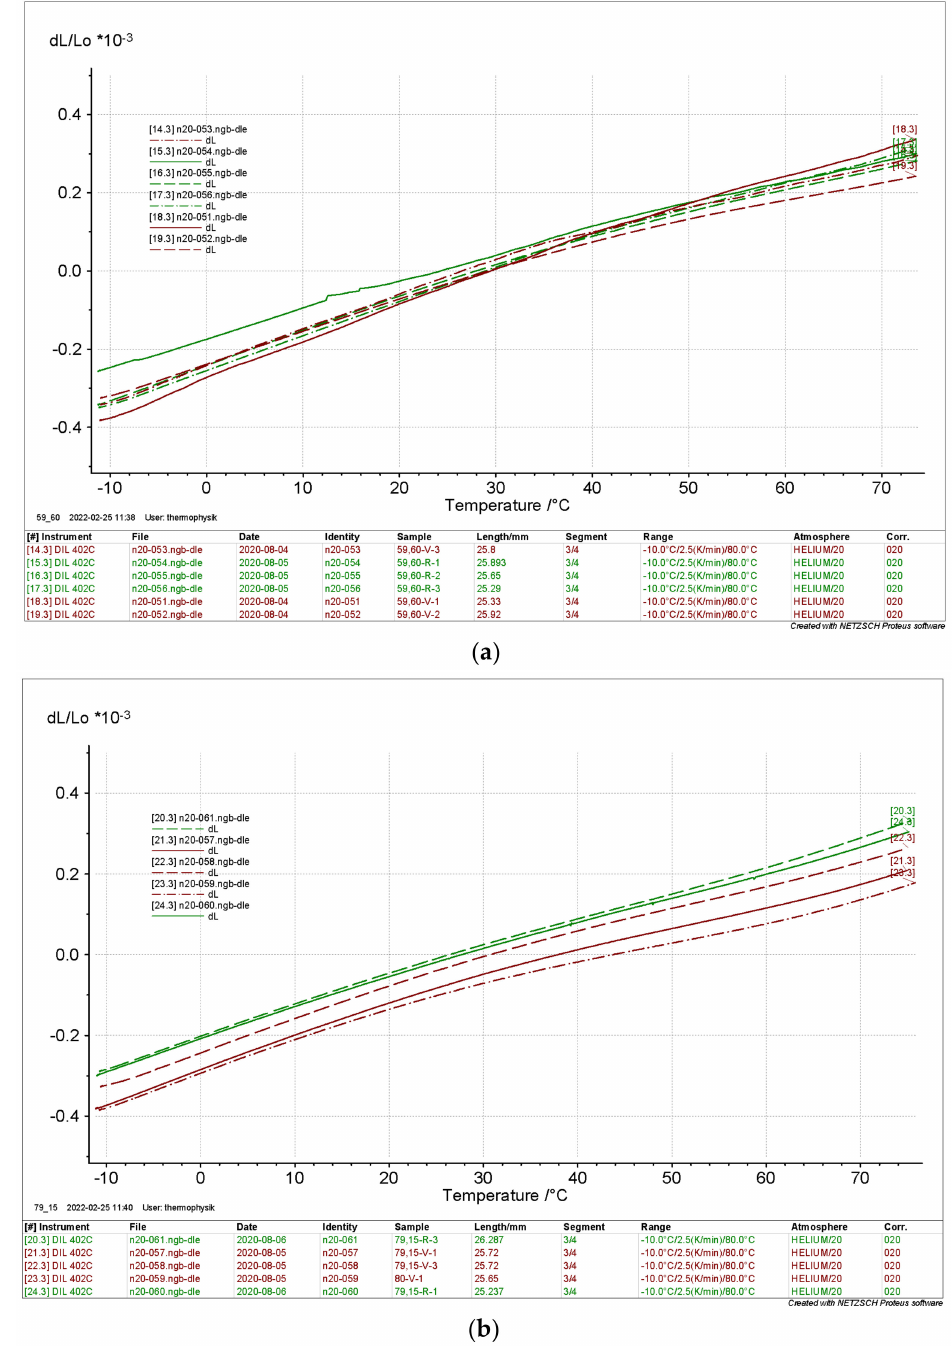
Figure 15. Summary of the results of the linear thermal expansion of the dry drill core samples from the depths of ( a ) 59.6 m and ( b ) 79.15